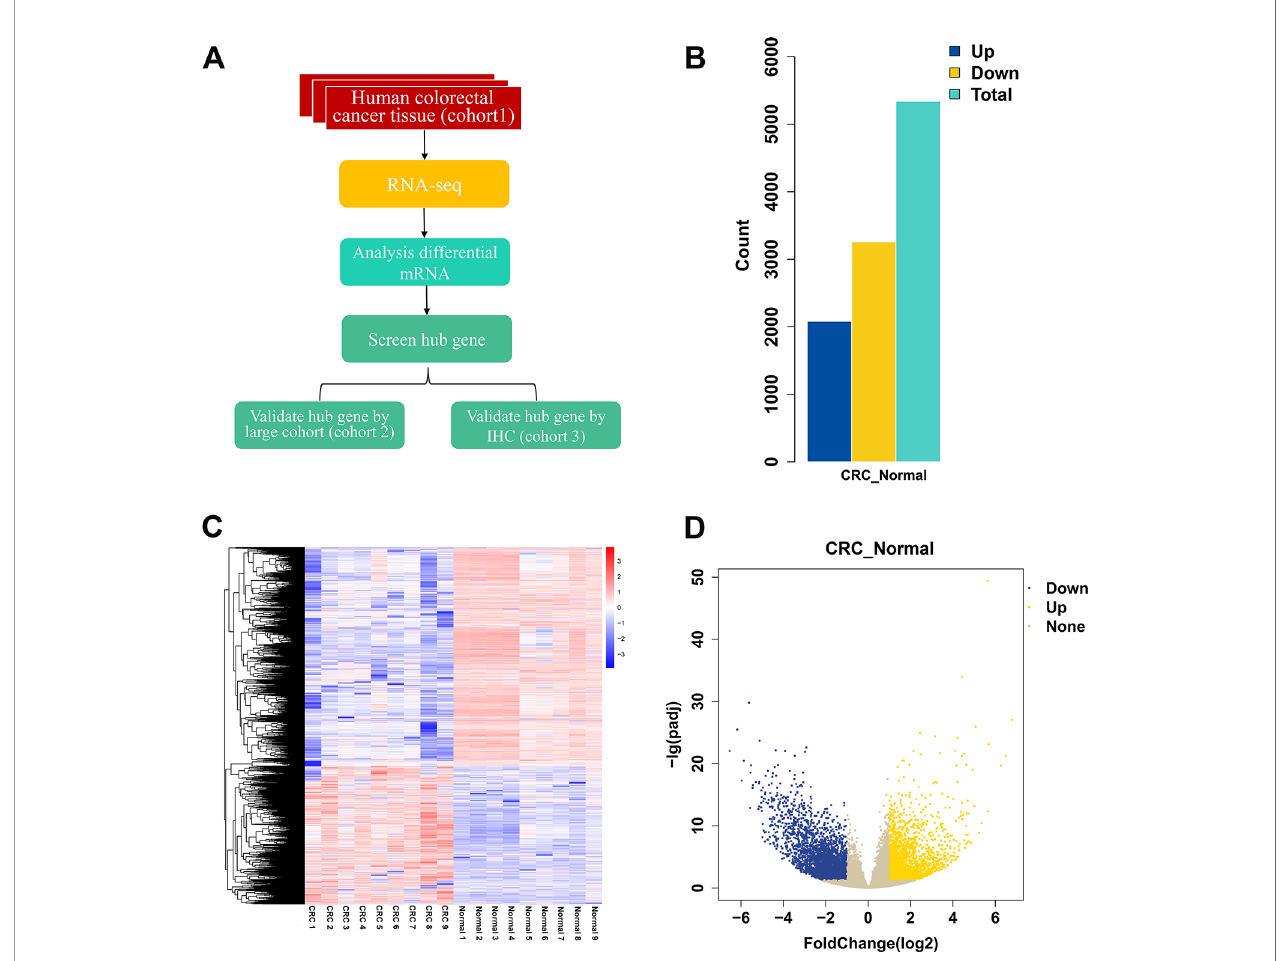
FIGURE1 | Differential gene expression between cancer and normal tissues of patients with CRC. (A) Work fl ow of the study. (B) The numbers of upregulated and downregulated genes. (C) Heatmap of differentially expressed genes between normal group and CRC group. (D) Volcano plot of differentially expressed mRNAs between normal group and CRC group. N = 9. CRC, colorectal